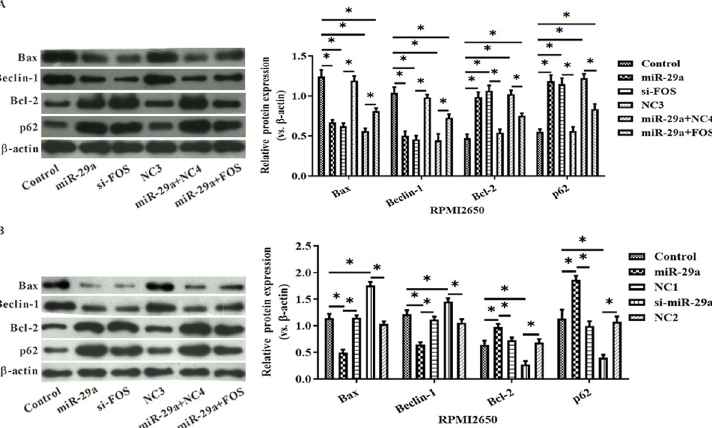
Fig 6. The effects of miR-29a on the expression of Bax, Beclin1, Bcl-2 and p62 in RPMI2650 cells (A) and HNEpC cells (B) were analyzed by Western Blot. � :p < 0.05.